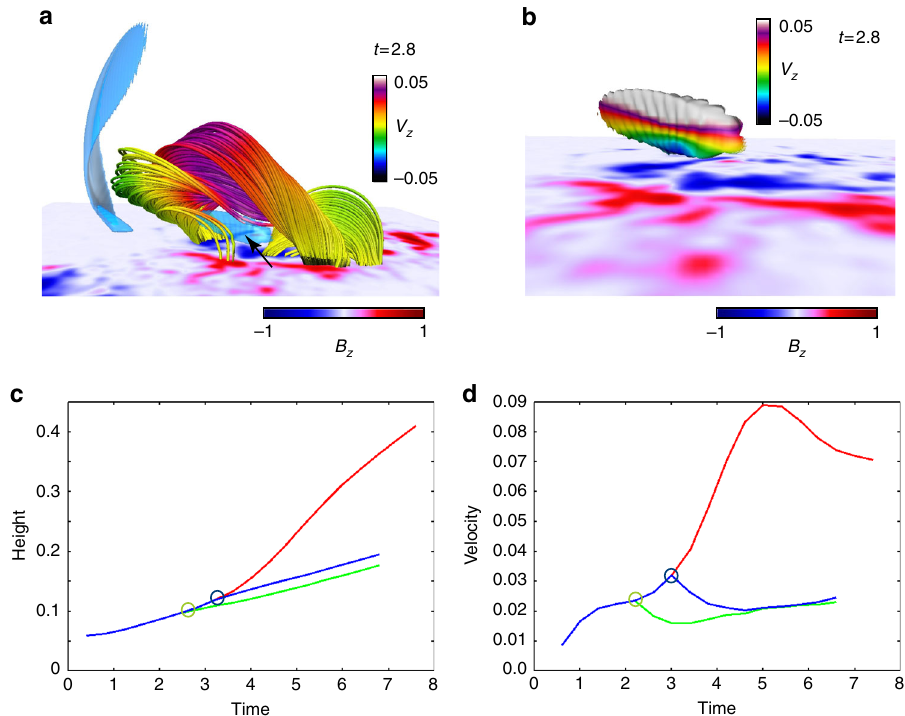
Fig. 7 Hypothetical experiments for forcibly suppressing the reconnection. a Three-dimensional fi eld lines at t = 2.8 which are identical format to those in Fig. 4 except the blue surface corresponds to the isosurface of | J | / | B | = 150. b A closeup of the surface, indicated by arrow in a drawn by V z distribution. Reconnection during the eruption is suppressed here setting all velocity components to zero. c The temporal evolution of the height pro fi les obtained from each calculation. Green, and blue lines are obtained from the hypothetical experiments in which the reconnection is suppressed at t = 2.0 and 2.8, respectively, while the red line is obtained from the original calculation, i.e., the reconnection is not suppressed. d The temporal evolution of the velocity pro fi les obtained from each calculation. The format is identical to